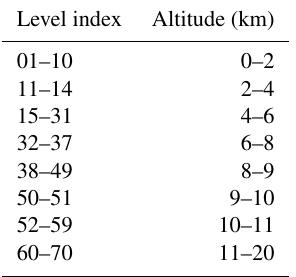
Table 1. Vertical levels prescribed in WRF-Chem